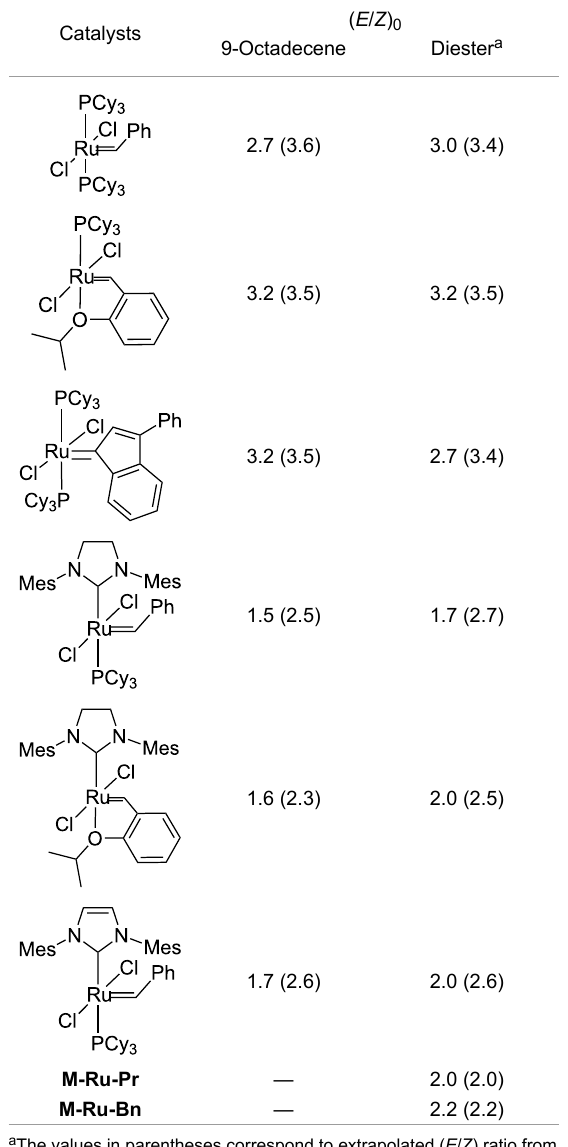
a The values in parentheses correspond to extrapolated ( E / Z ) ratio from the extrapolated value at the steady